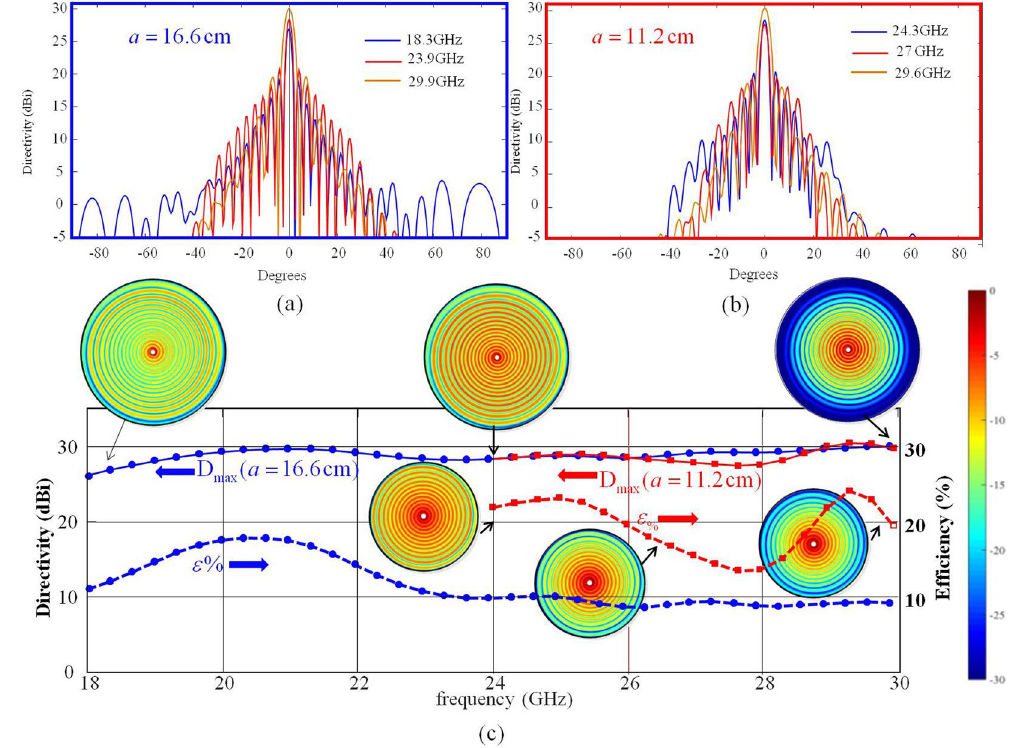
Figure 7. Performances of the wideband MTS prototypes; ( a ) and ( b ) represent directivity patterns obtained with the “continuous impedance“ MoM model for the 16.66 cm radius antenna ( a ) and for a 11.11 cm radius antenna at different frequencies. ( c ) Maximum directivities (solid lines, left scale) and efficiency (dashed lines, left right scale) versus frequency of the two wideband antennas. The insets in ( c ) represent the surface current distribution for both antennas at the same frequency samples used in ( a , b